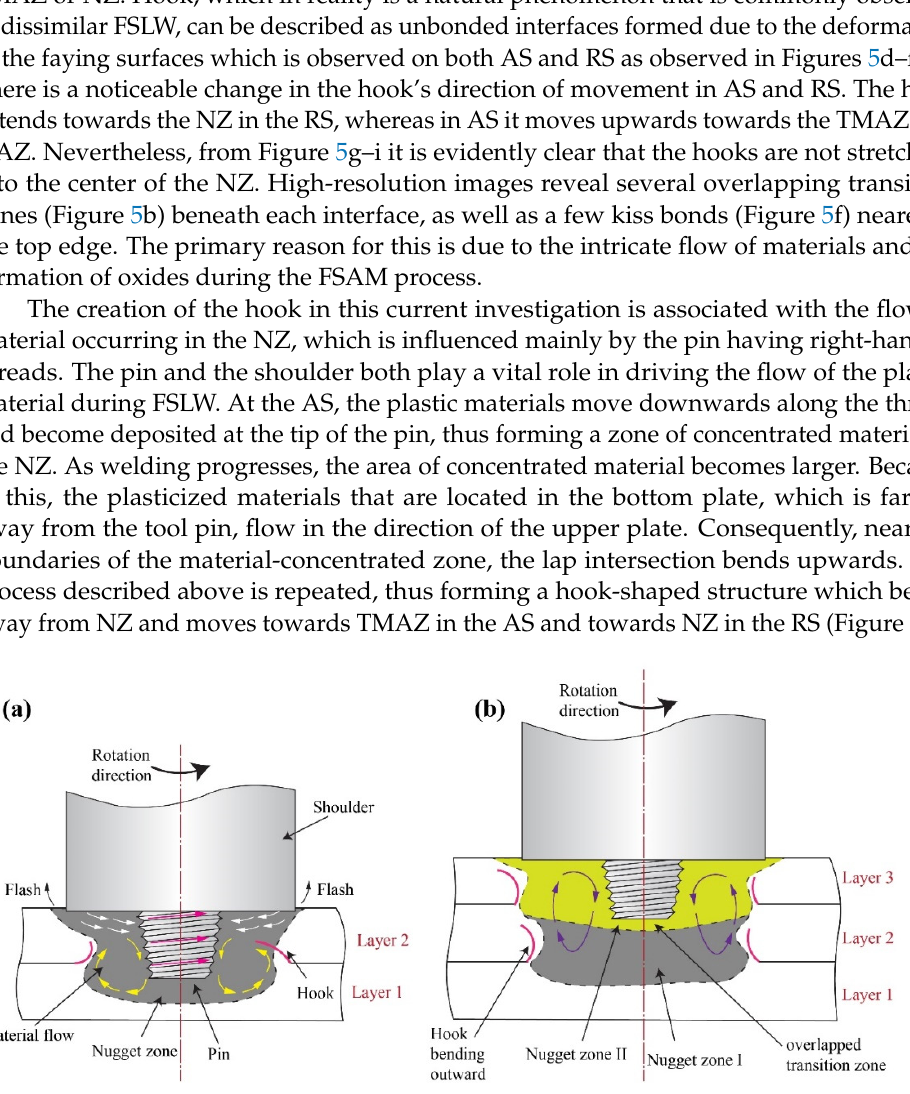
Figure 6. Schematic diagram of metal flow ( a ) with two plates and ( b ) with multiple plates.